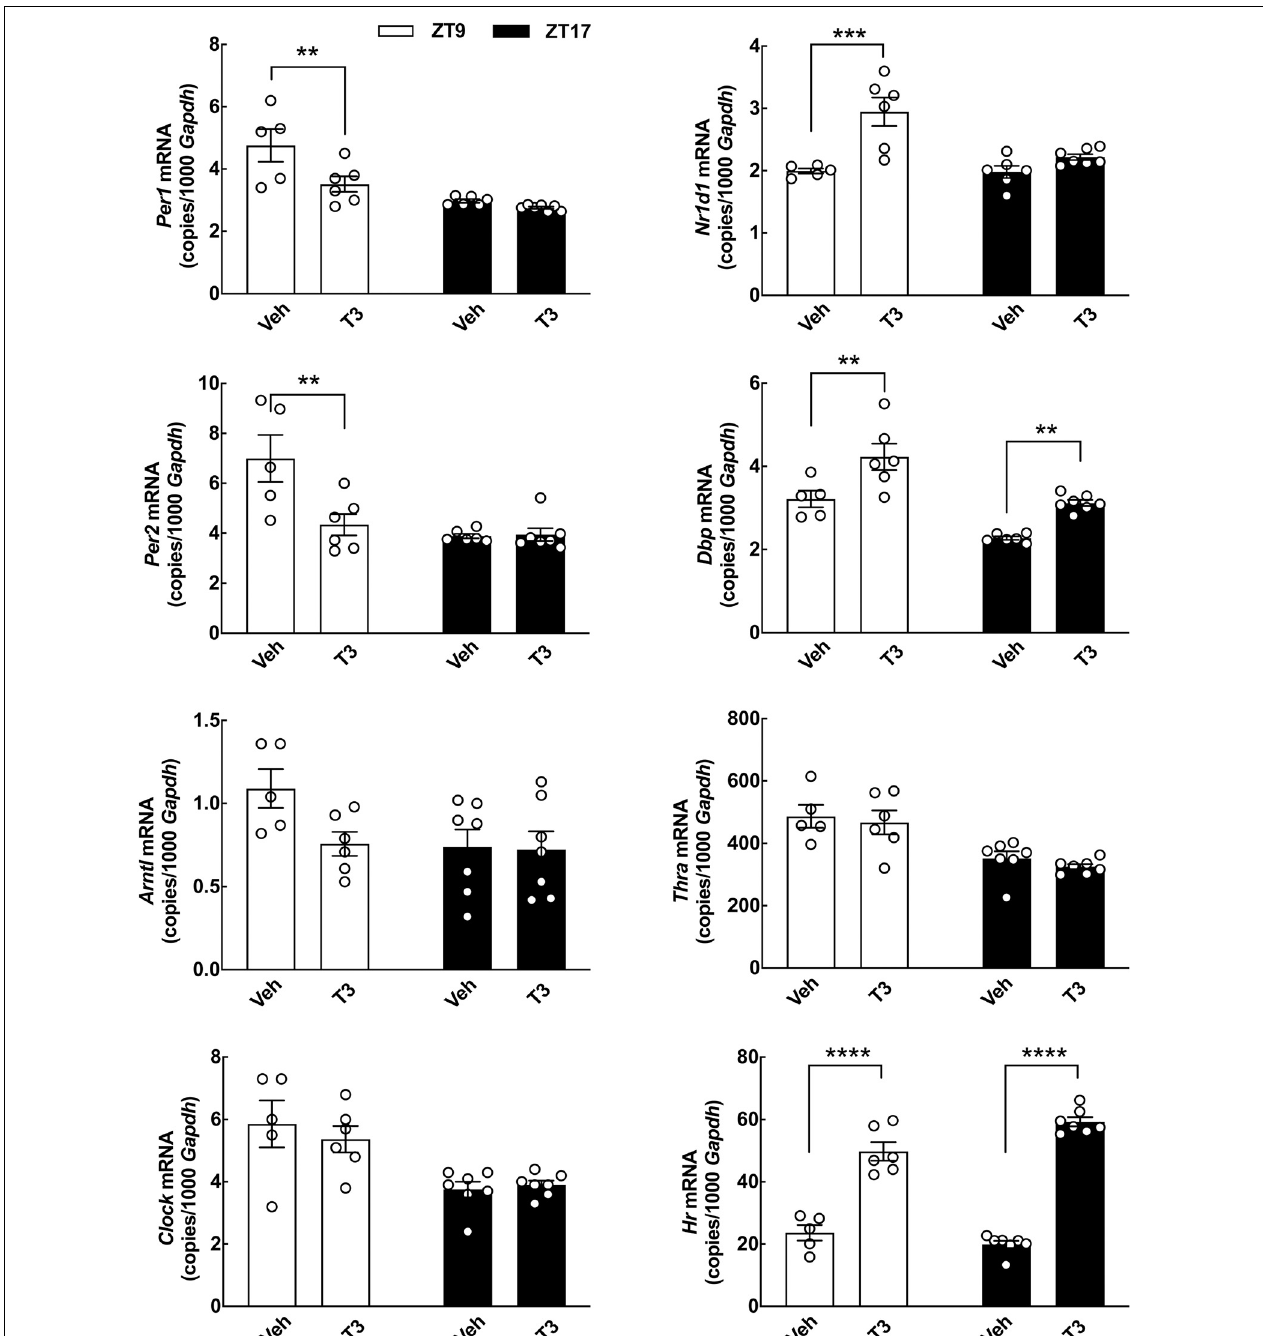
FIGURE 7 | Acute effects of T3 on cerebellar clock gene expression in neonatal rats determined by qRT-PCR. Rat pups (postnatal day 7) received 0.1 mg/kg T3 by IP injection at ZT5 and were subsequently euthanized at ZT9 or ZT17. Littermate controls received vehicle (Veh). Quantitative data were analyzed by two-way ANOVA followed by Bonferroni multiple-comparisons tests. Significance levels of Bonferroni multiple-comparisons tests are displayed. ** p < 0.01; *** p < 0.001; **** p < 0.0001. n = 5–7.